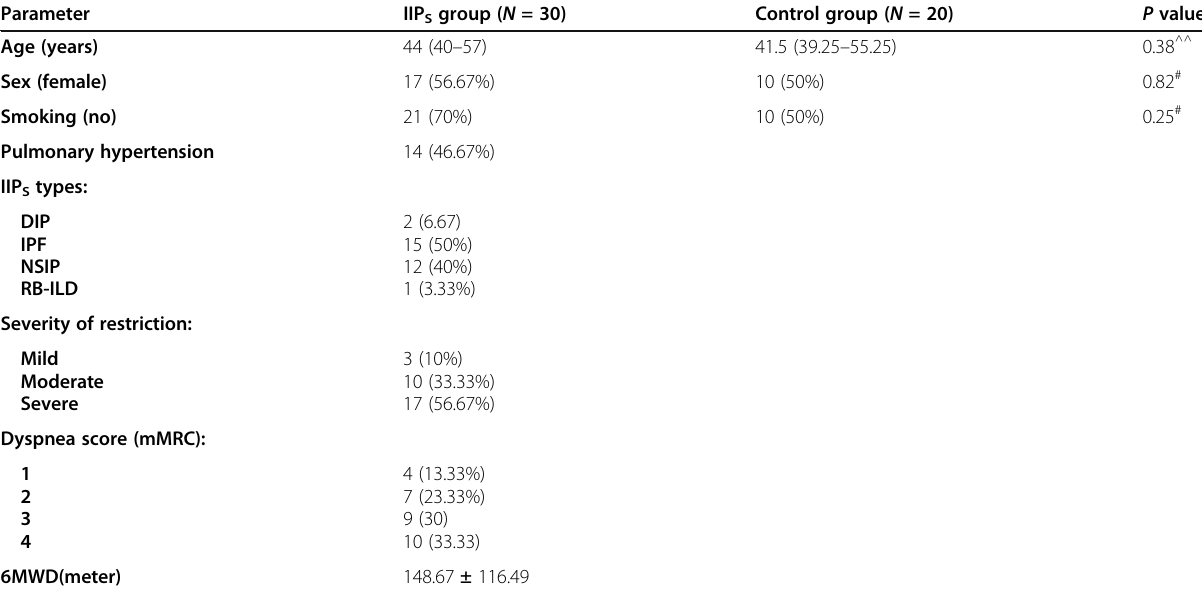
Table 1 The clinical characteristic of the study population Parameter